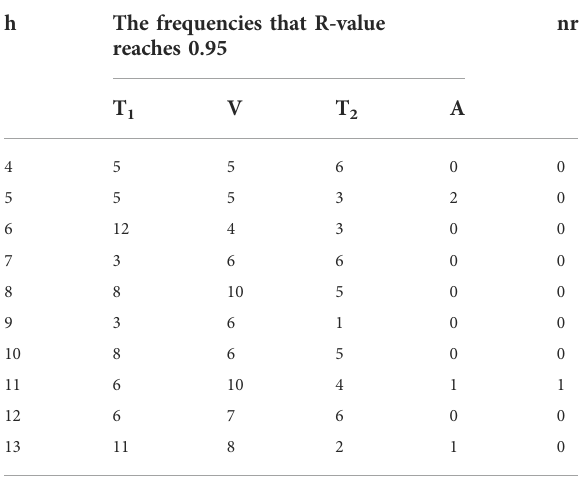
TABLE 2 Principal Components and their contribution rates (PCA was performed on the matrix consisting of descriptors with molecular interaction-based features).